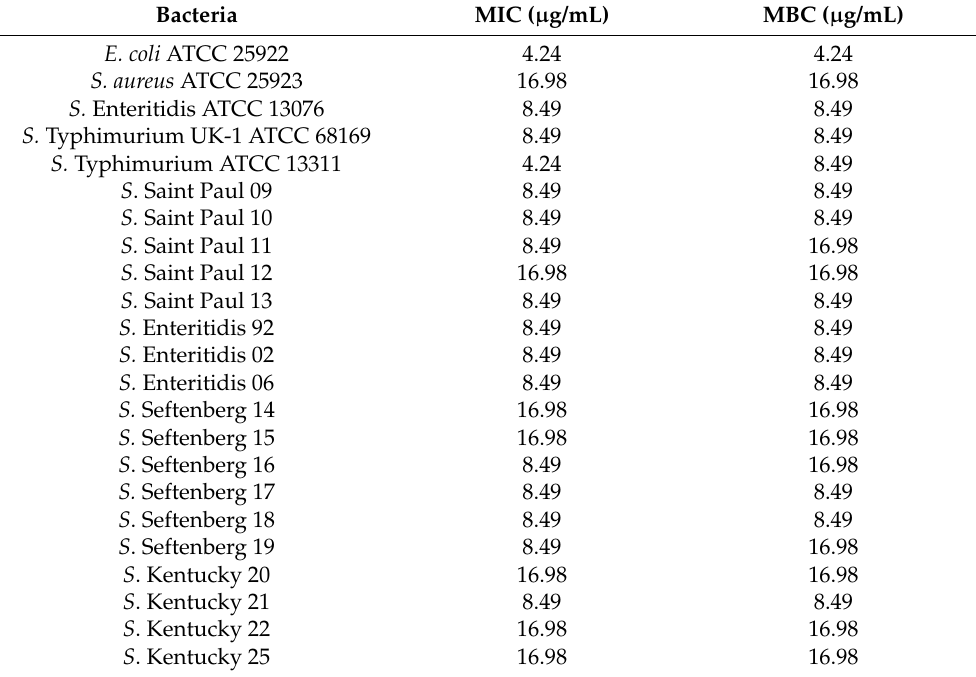
Table 1. Values of MIC and MBC of